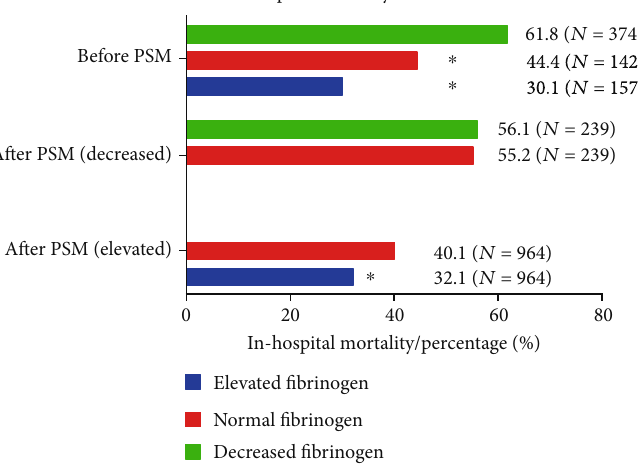
Figure 3: A brief summary of inhospital mortality before and after PSM. ∗ P < 0 : 001 in the Chi-square